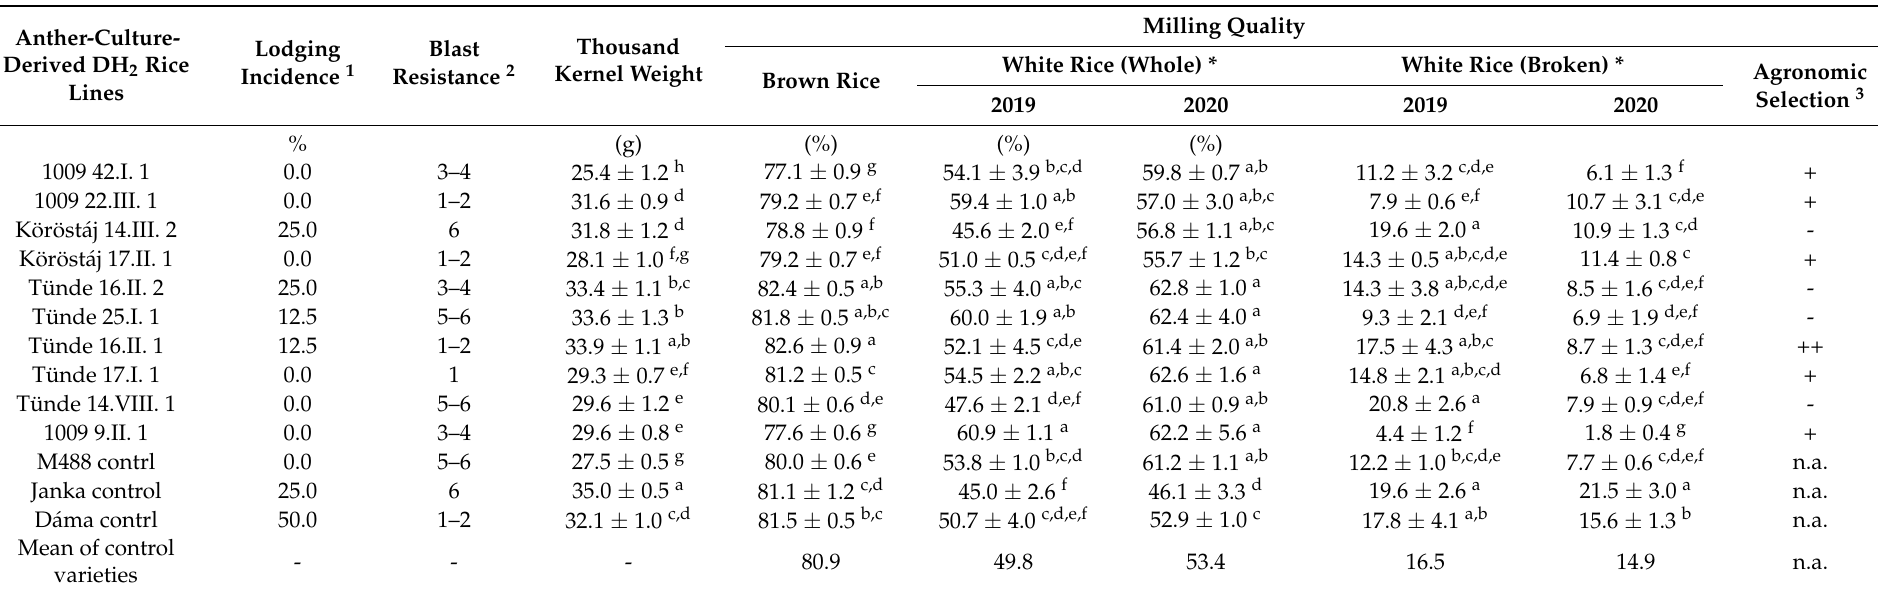
Table 8. Main agronomic and grain quality traits of anther-derived DH 2 lines in small-scale temperate rice field experiment (Szarvas, Hungary, 2019–2020).